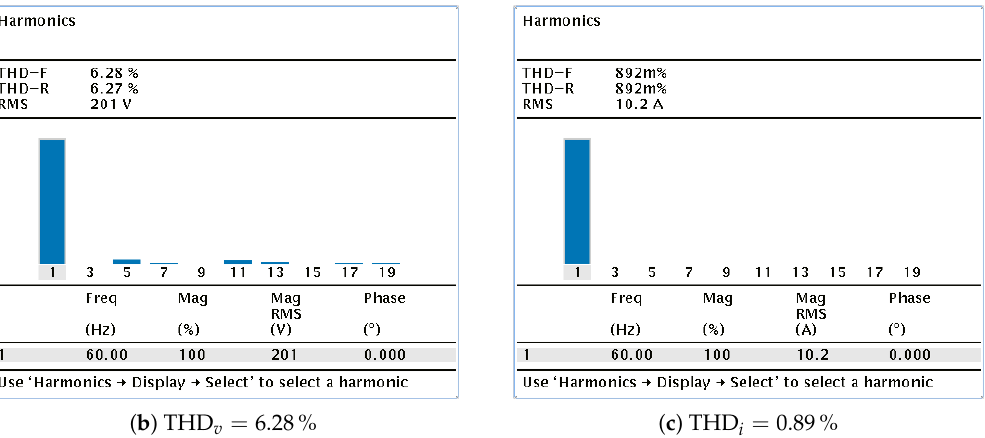
Figure 13. Experimental results in steady state: ( a ) Converter currents with low harmonic distortion even with grid distorted voltage; ( b ) Harmonic voltage analysis; ( c ) Harmonic current